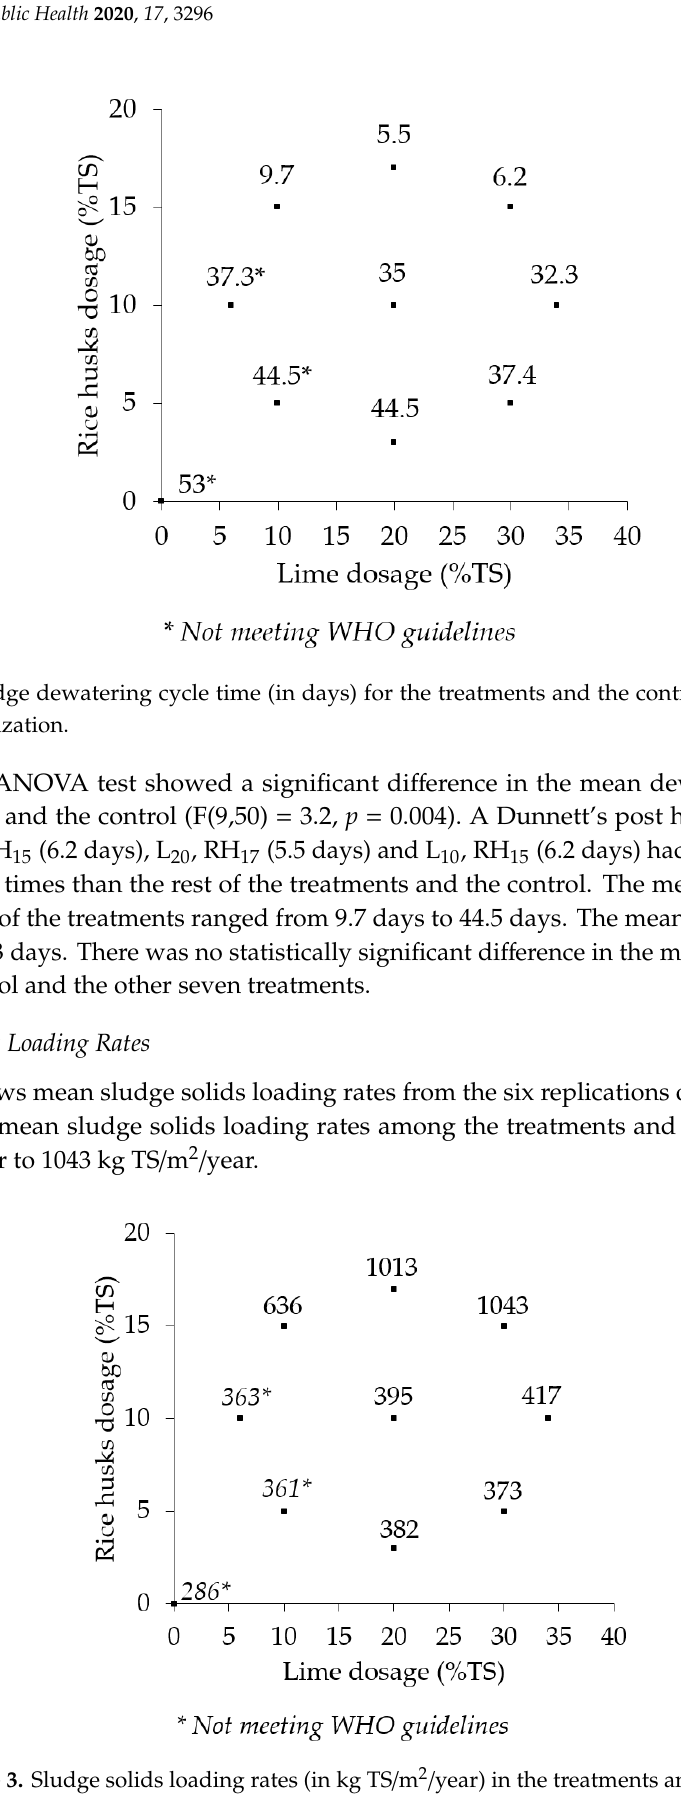
Figure 3. Sludge solids loading rates (in kg TS/m 2 /year) in the treatments and control.